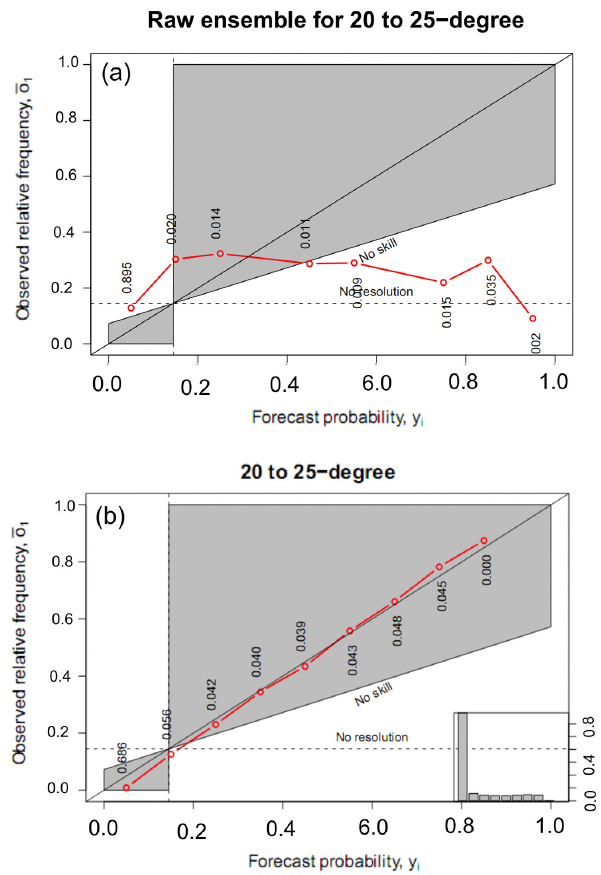
Fig. 9. Attribute diagrams for (a) raw ensemble and (b) BMA for “20 to 25 ◦ C” interval. In this figure a horizontal “no resolution” line is drawn at the climatological frequency. A vertical line is also drawn for a forecasted probability at the observed frequency, a “per- fect reliability line” is also drawn with a slope of 1.